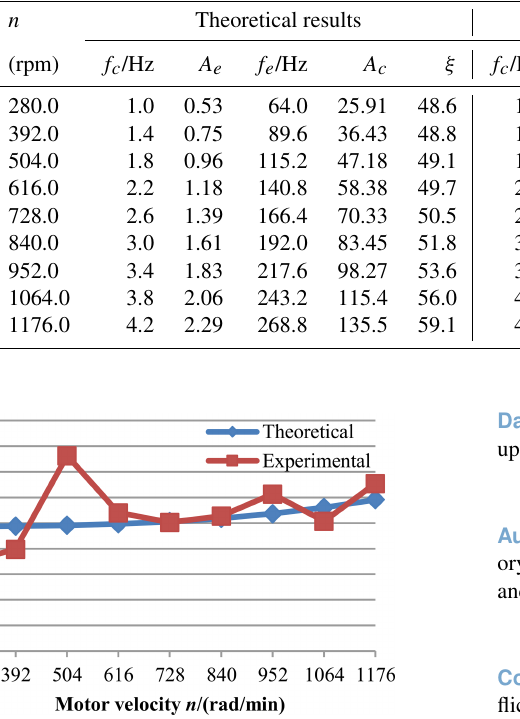
Figure 18. Comparison of the ratio of